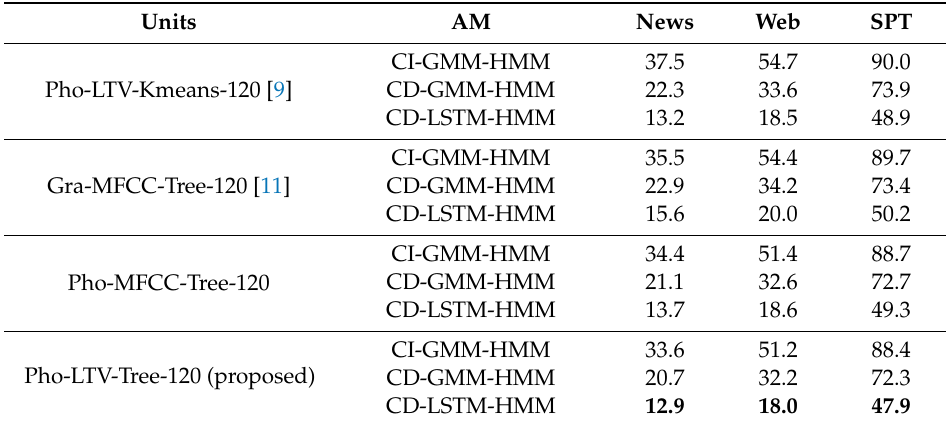
Table 5. Word error rate (%) of the subword units obtained by various methods.